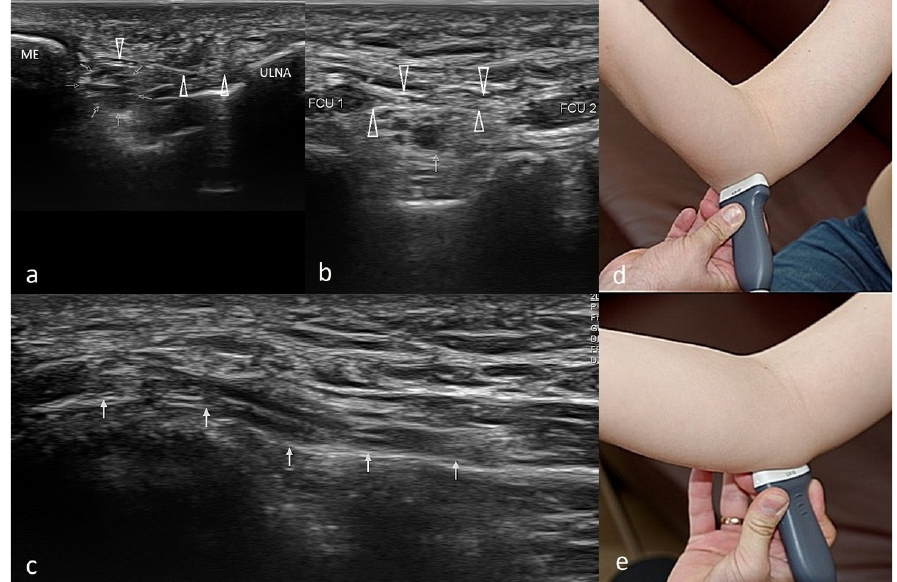
Figure 5. Ultrasound examination of the ulnar nerve. ( a )—Short-axis view at the level sulcus of the nerve; small arrows—ulnar nerve; open arrowheads—Osborn’s ligament; ME—medial epicondyle. ( b )—Short-axis view just distal to the medial epicondyle; small arrow—ulnar nerve; FCU1—humeral head of the flexor carpi ulnaris; FCU2—ulnar head of the flexor carpi ulnaris; arrowheads—Osborn’s band connecting proximal parts of both heads of the flexor carpi ulnaris. ( c )—Long-axis view of the ulnar nerve-arrows; ( d , e )—a method of applying the probe to obtain both ( d )—transverse and ( e )—longitudinal sections.